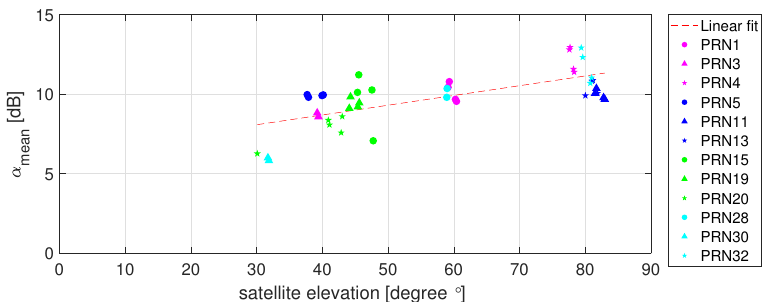
Figure 7. The reflected power from the lake α mean VS. satellite elevation.